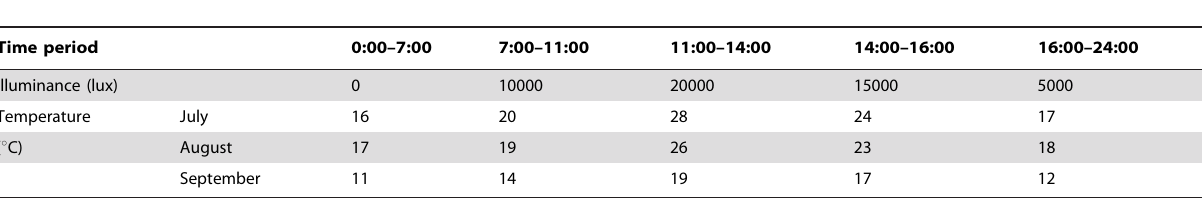
Table 1. Temperature and illuminance control for plants’ incubation in the environmental chambers.